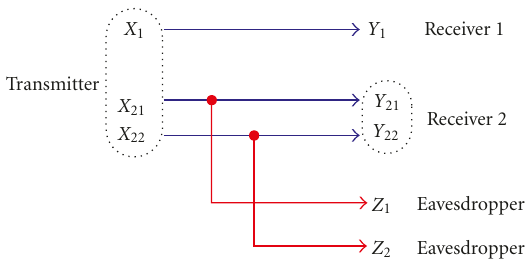
Figure 4: Parallel Gaussian compound wiretap channel